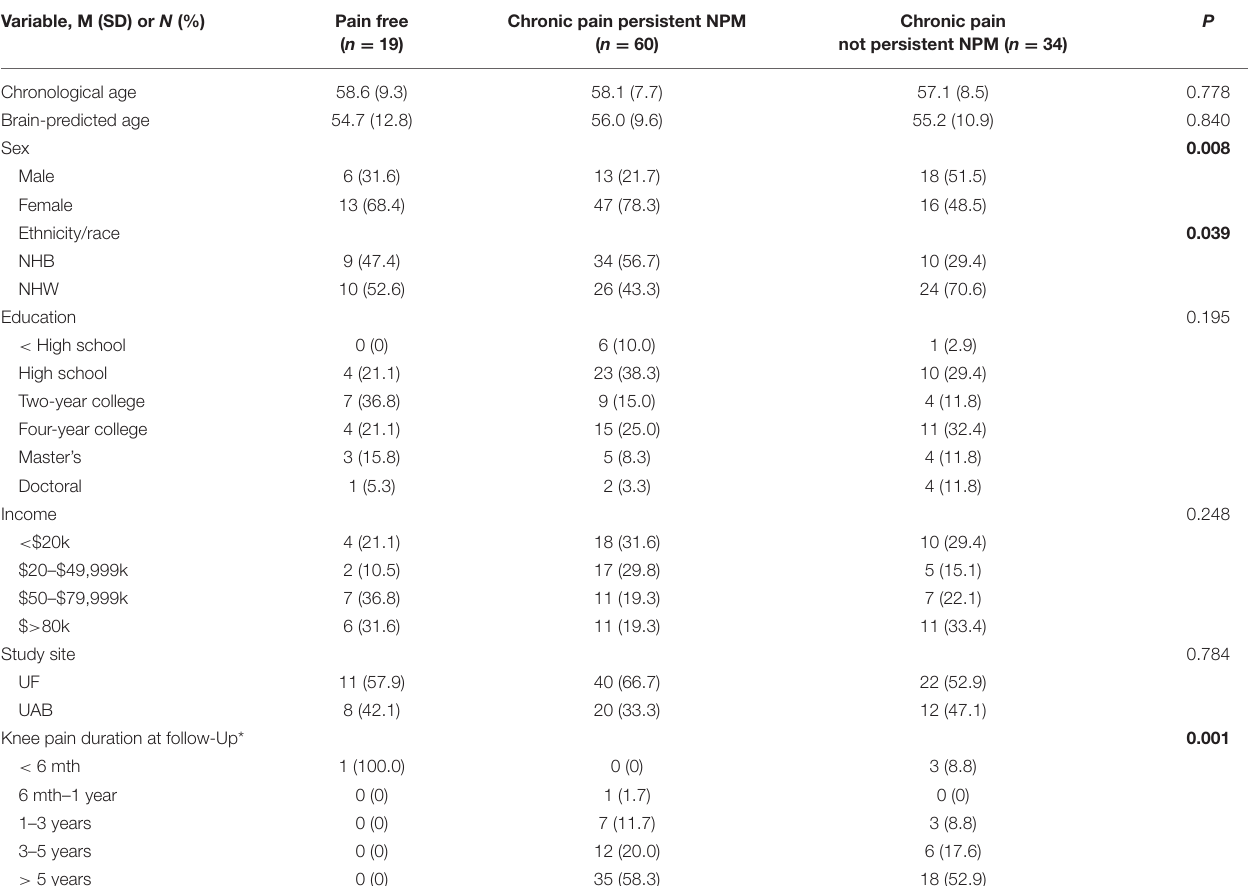
TABLE 1 | Sample demographic and clinical characteristics at baseline. Variable, M (SD) or N (%)